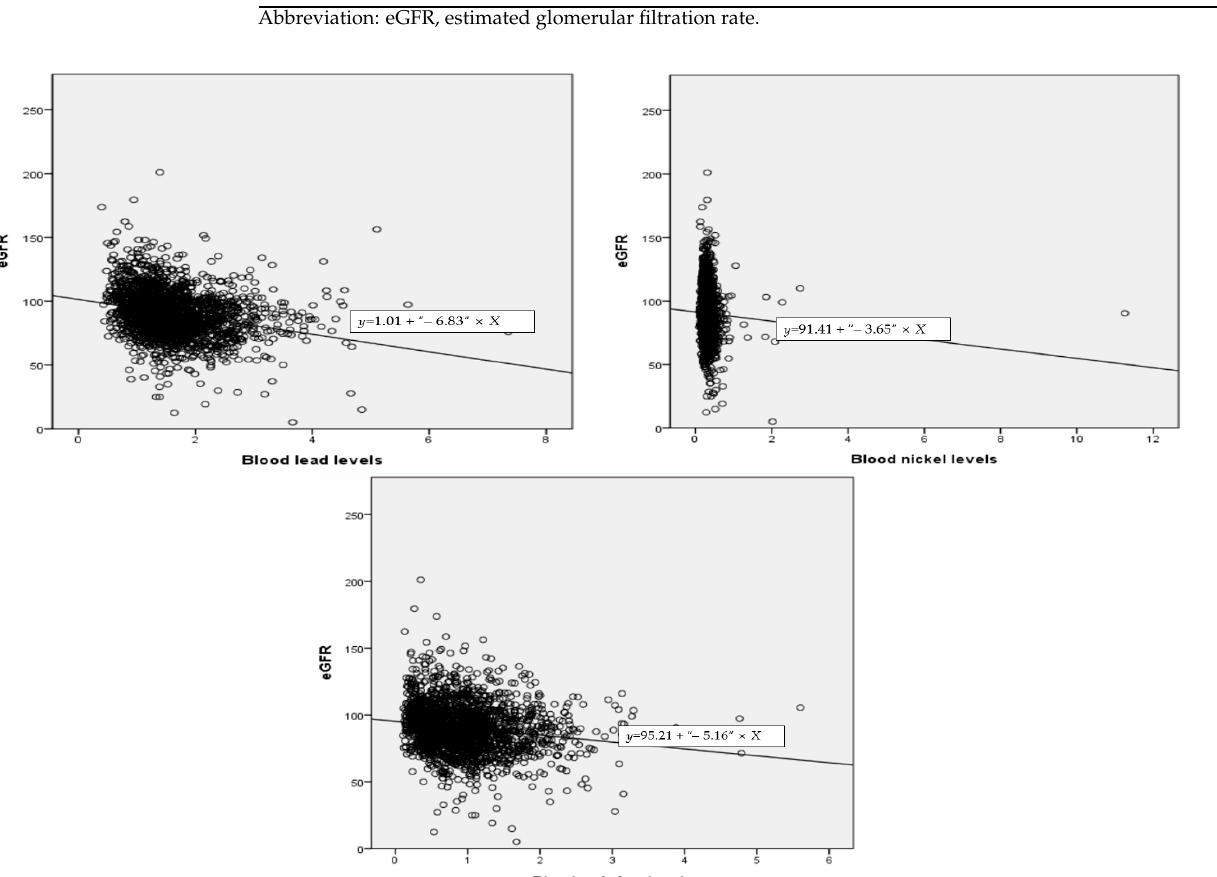
Figure 2. Scatter plot of blood lead, nickel, and cadmium levels and eGFR.